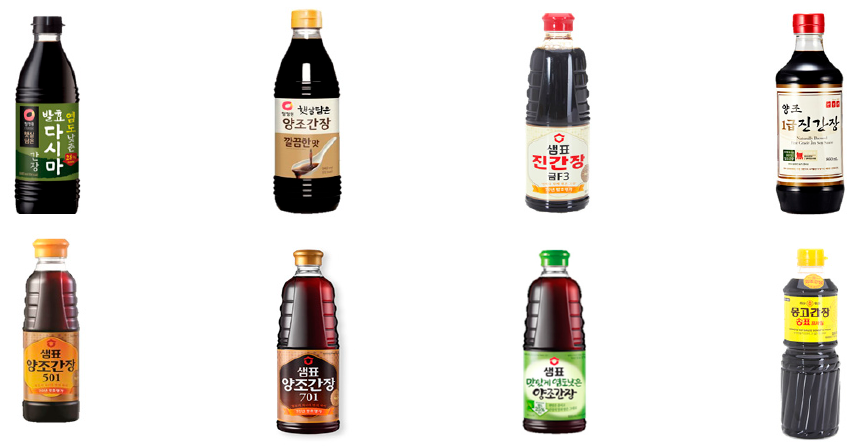
Figure A1. Soy sauce products used as stimuli in the survey.